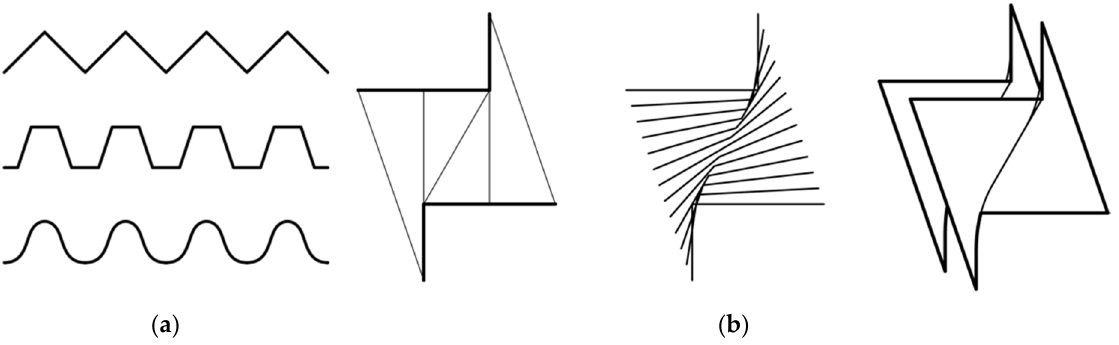
Figure 6. ( a ) Examples of poly-line- and poly-curve-based periodic curves generated with the parametric design script for designing serpentine walls; ( b ) three-dimensional extractions and transformations afforded by the script. Vertical slicing and thickening were both used to design formwork schemes and to estimate material volume requirements.